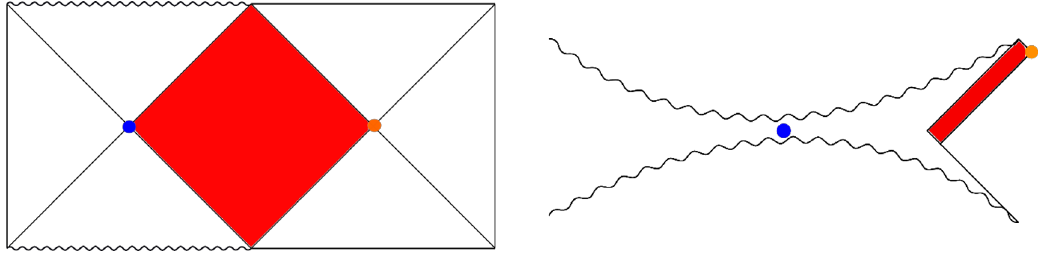
Figure 5 . Left: the causal diamond D (Σ) in the spacetime without backreaction. Right: the same causal diamond D (Σ) in the backreacted black hole in the high temperature limit. The causal diamond shrinks to an almost null line connecting the black hole event horizon and the cosmological event horizon.